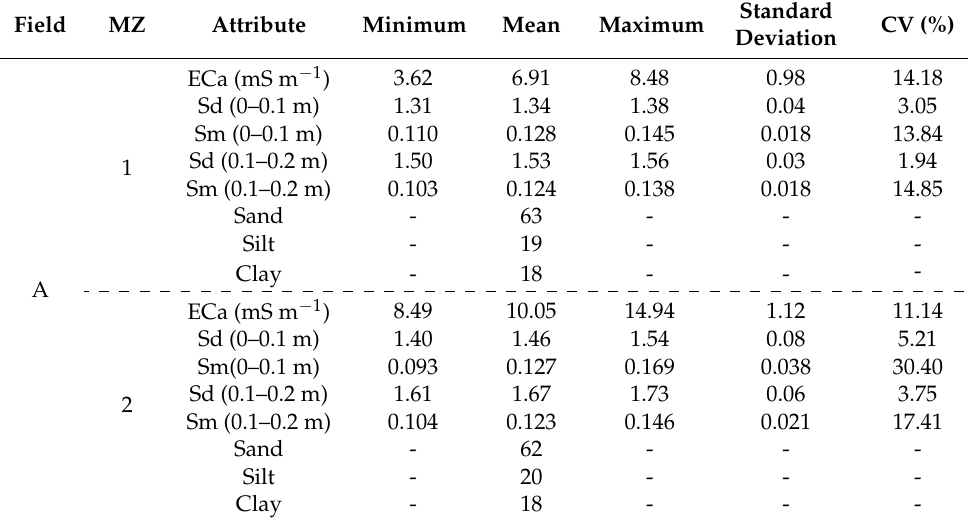
Table 1. Descriptive statistics of soil attributes: Apparent soil electrical conductivity (ECa; mS m − 1 ), soil bulk density (Sd; g cm − 3 ), soil moisture (Sm, g g − 1 ), sand, silt, and clay contents, for the delimited management zones (MZs) in field A. Cachoeira do Sul, RS, BR.